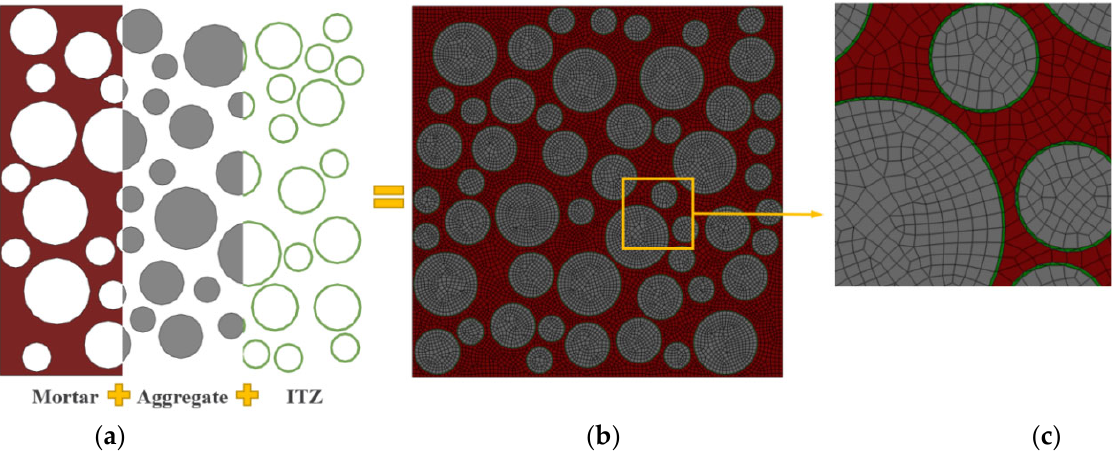
Figure 20. Mesoscale of LHPCC specimen model. ( a ) Three ‐ phase material; ( b ) meshing grid; (c) details of the meshing.